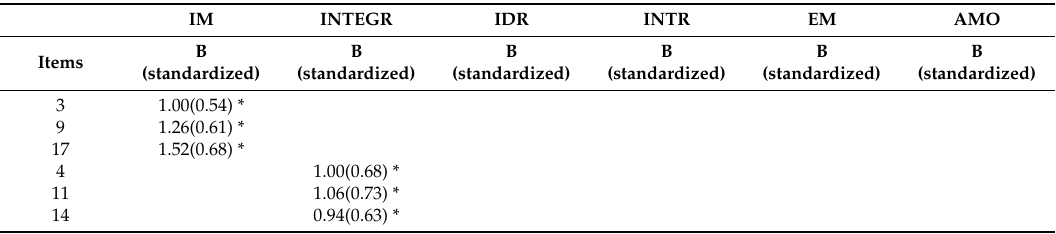
Table 2. Parameters of the model of six correlated factors